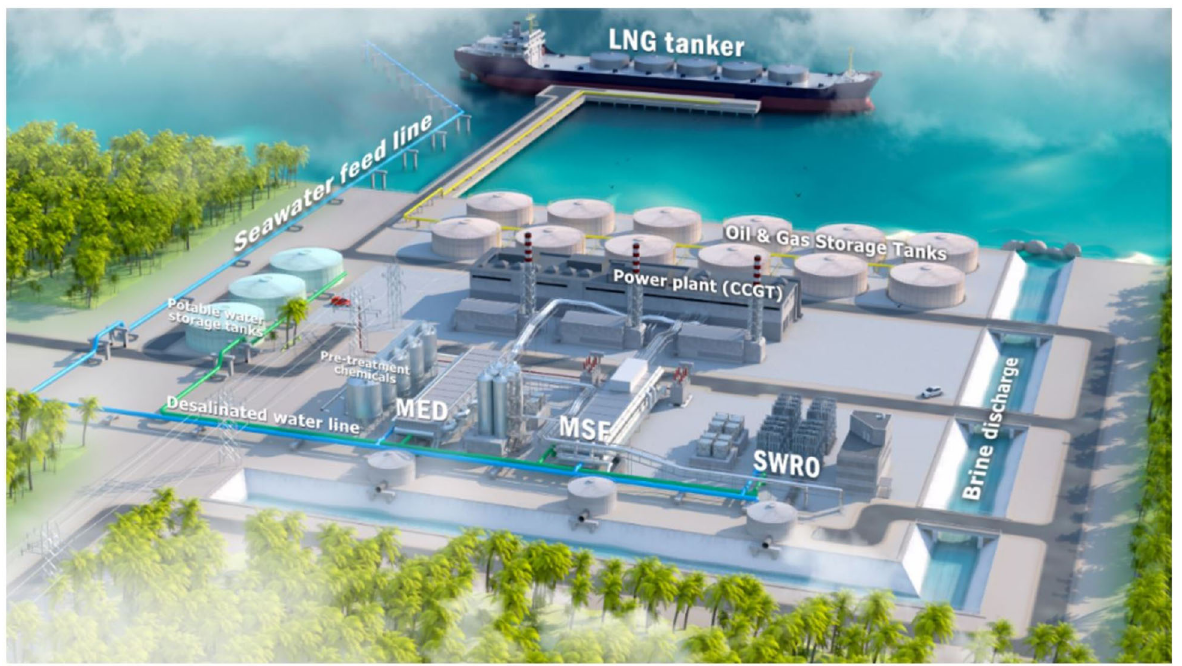
Fig. 7 A pictorial representation of combined cycle gas turbines (CCGT) plant. A pictorial representation of combined cycle gas turbines (CCGT)